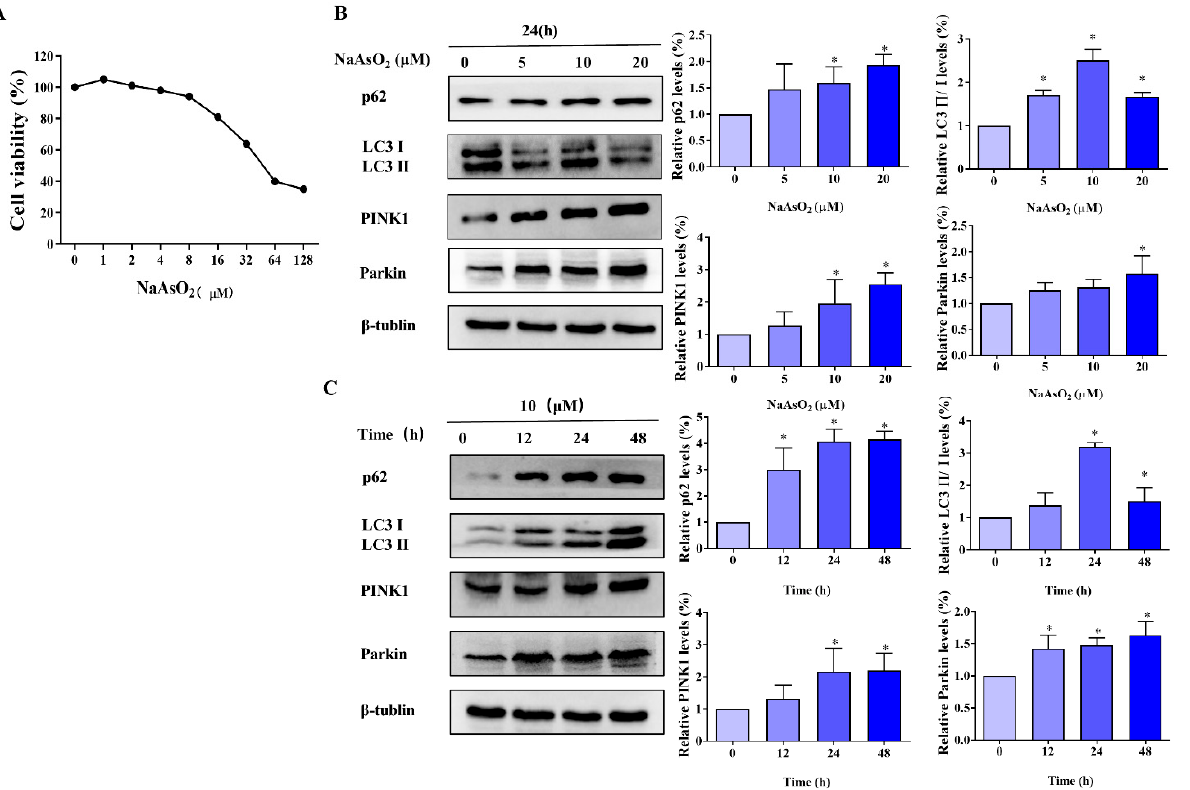
Figure 1 . As induces mitophagy in L-02 cells. ( A ) CCK8 assay was used to explore the most suitable exposure time and concentration for this experiment. ( B ) Western blotting was used to detect the effect of different concentrations of NaAsO 2 on autophagy-related proteins under different exposure times. ( C ) Western blotting was used to detect the effects of different exposure times on autophagy-related proteins under different concentrations of NaAsO 2 . * p < 0.05 compared with the control group.